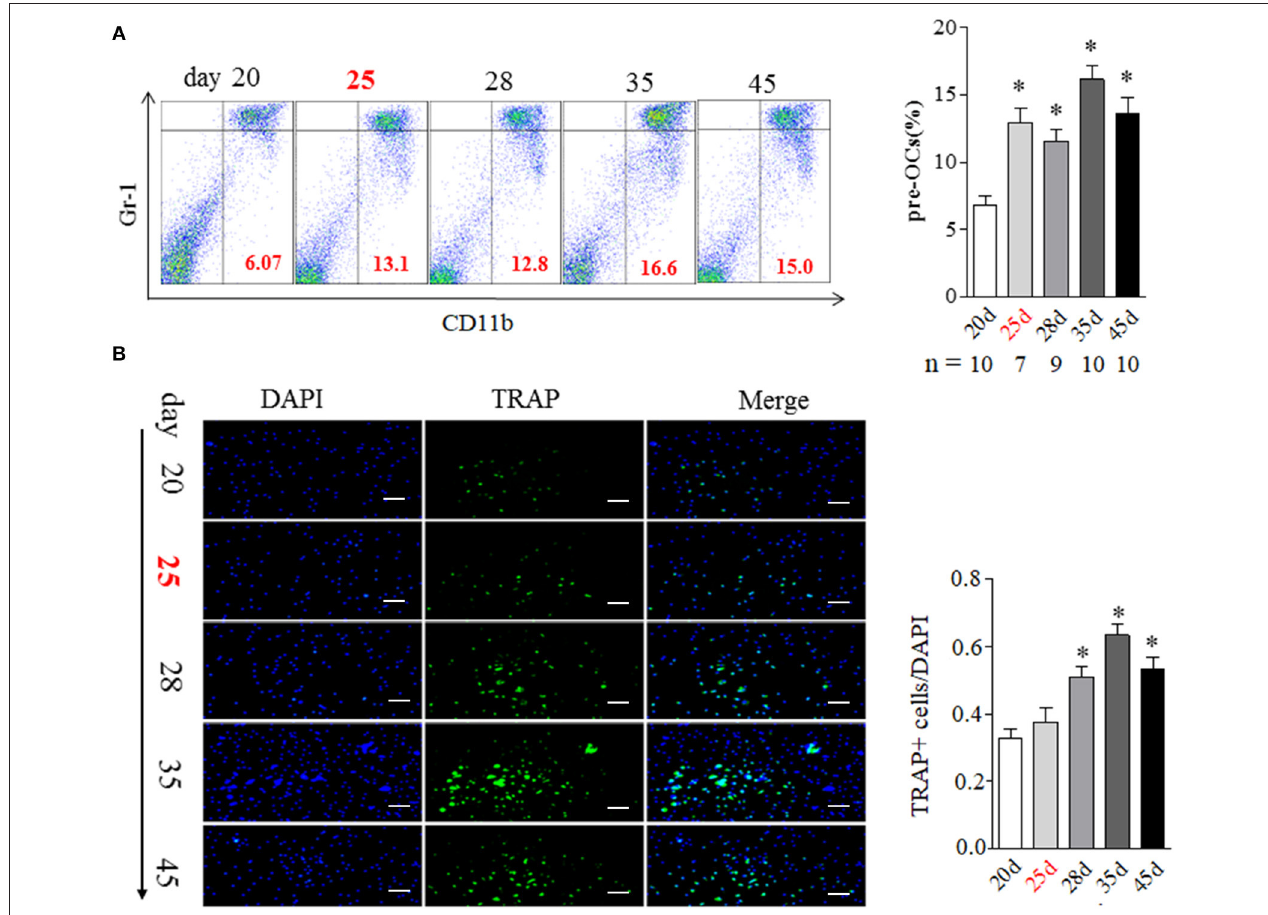
FIGURE 2 | BME links to the increased osteoclast formation in bone marrow during the development of CIA. (A) CD11b + Gr-1 low OCs precursors in bone marrow detected by flow cytometry. Graph show the quantitation data (sample size used in this experiment was indicated under the Graph). (B) TRAP positive cell in bone marrow detected by immunofluorescence staining ( n = 5). Values are means ± SD (* p < 0.05, compared with day 20). All experiments were repeated three times. Scale bar, 100 µ